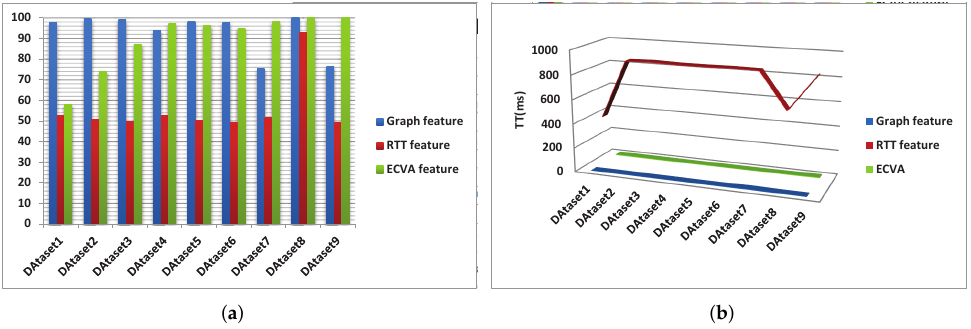
Figure 8. ( a ) Testing accuracy of the SVM across different feature sets and different datasets, and ( b ) training times of the SVM across different feature sets and different